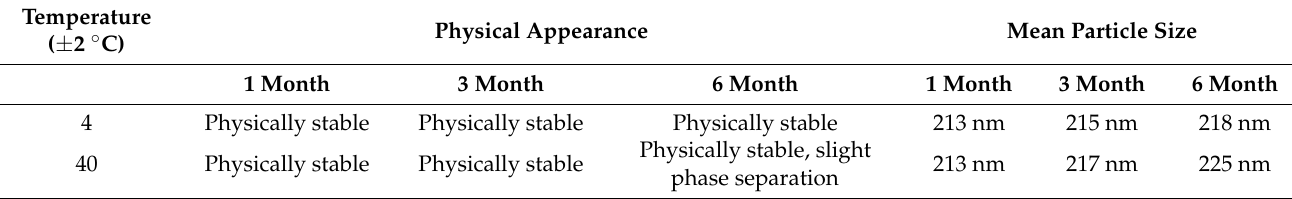
Table 5. Stability studies for SSD-based nanolotion.